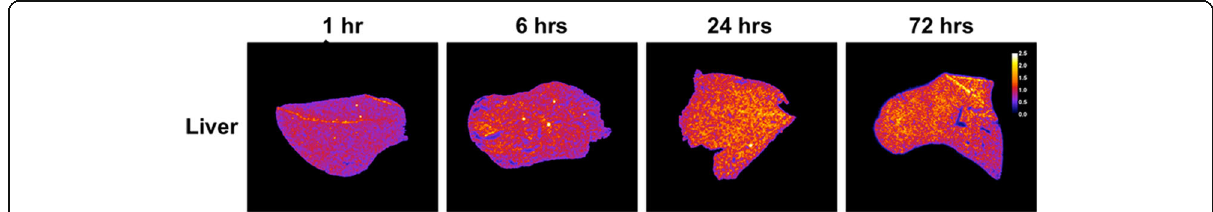
Fig. 8 Alpha-camera images for the liver following IV administration of 225 Ac-DOTA-anti-PD-L1-BC (67 kBq, 3 mg/kg). The scale is normalized so that the average intensity over time is set to